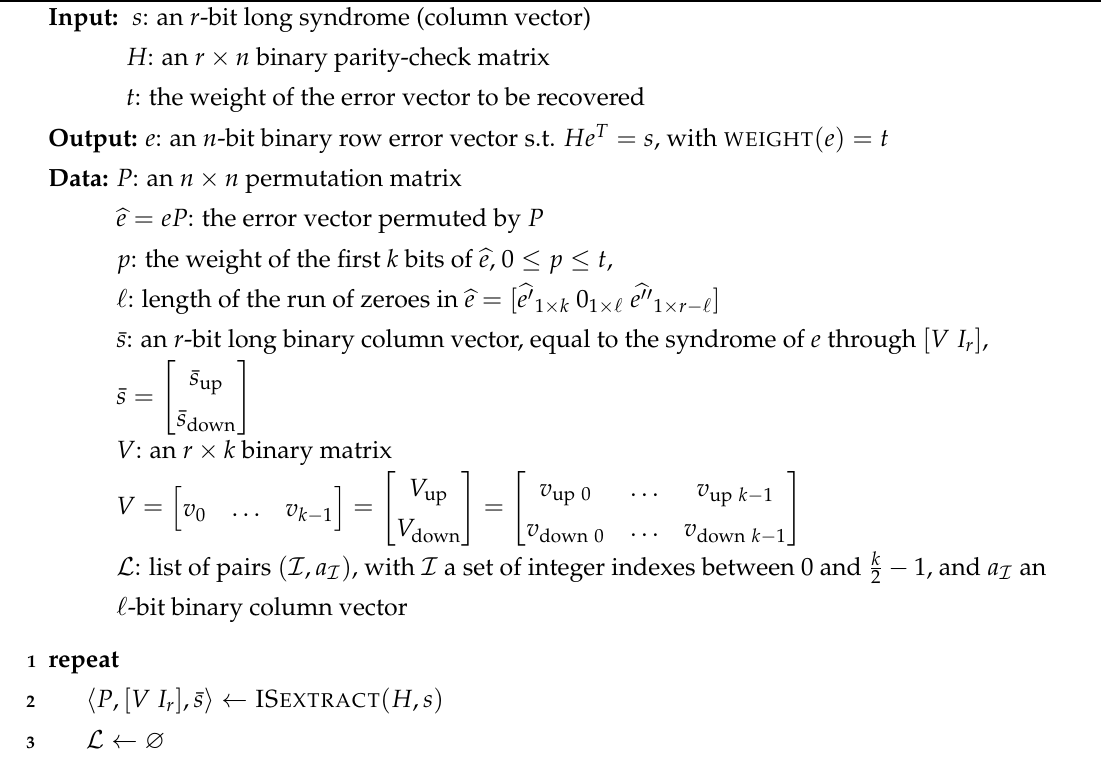
Algorithm 5: Syndrome decoding formulation of Stern’s